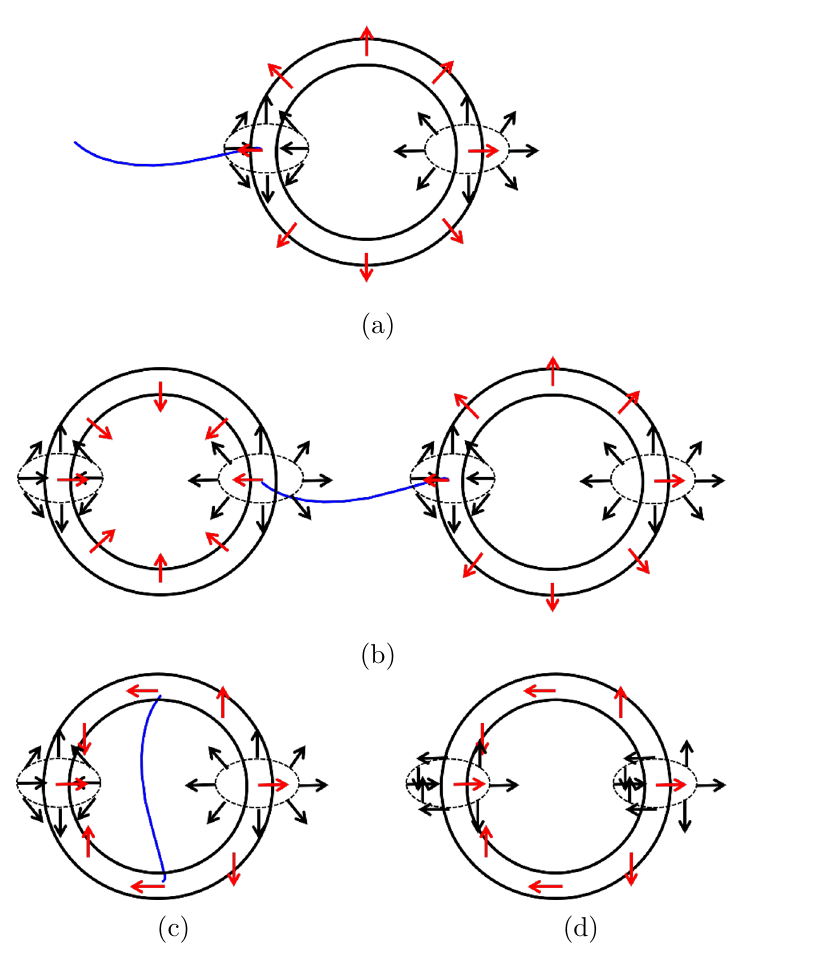
Figure 7 . Confined monopoles in the deconfined phase. (a) A monopole of the charge one is attached by an AB defect. (b) Two monopoles of the charge one are connected by an AB defect. (c) A doubly-twisted Alice ring as a monopole of the charge two. (d) A singly twisted double- winding Alice ring as a monopole of the charge